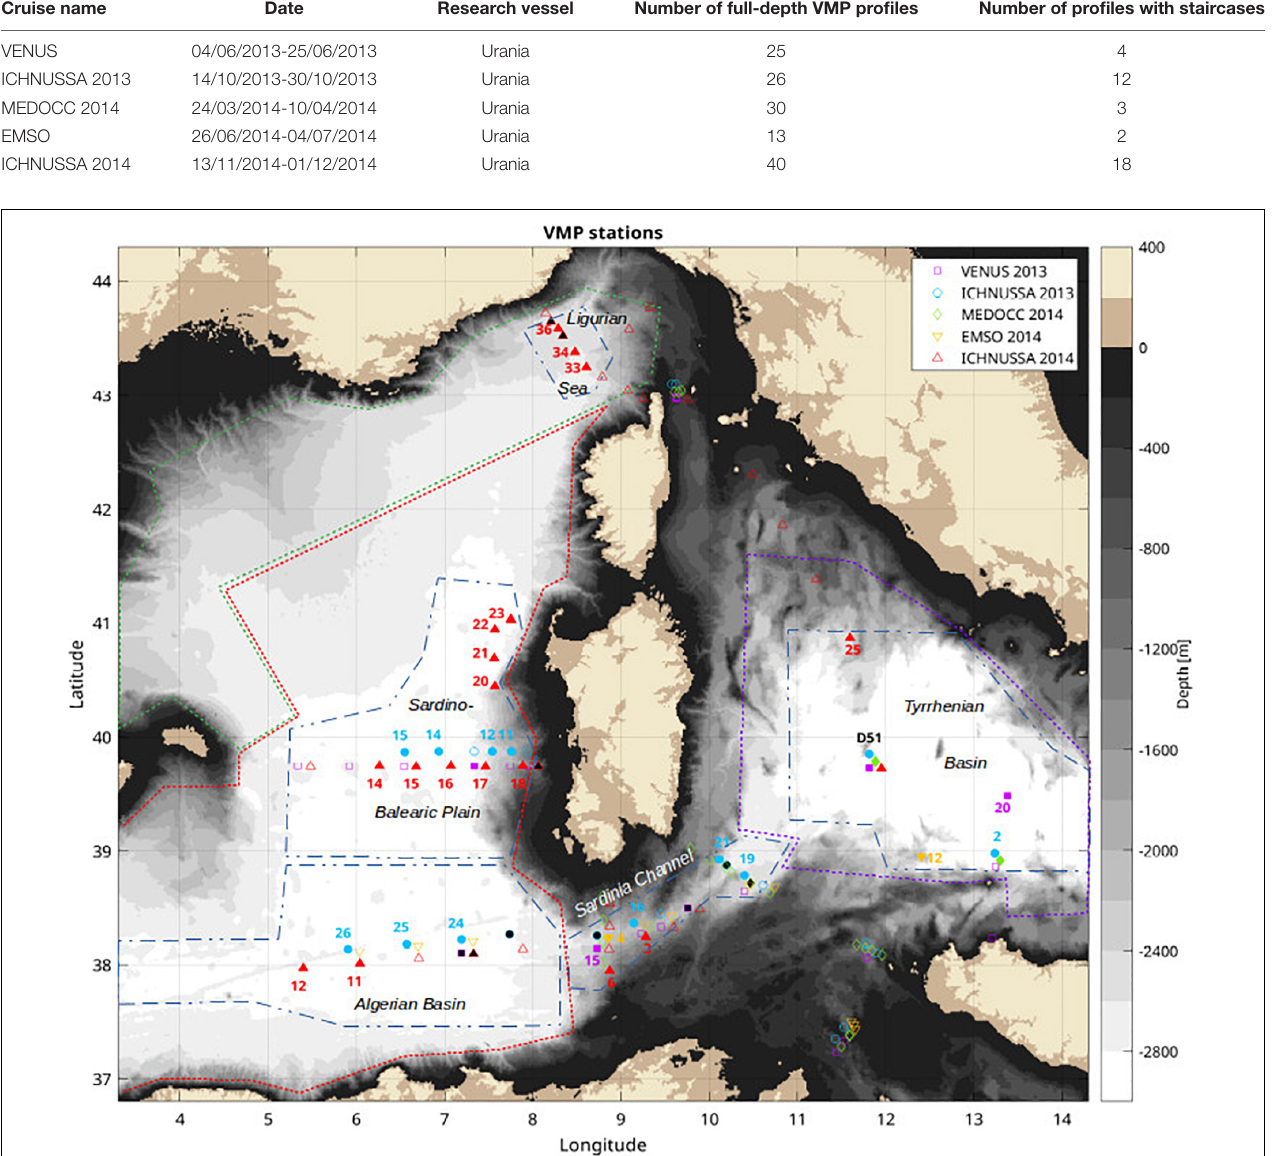
FIGURE 1 | Location of VMP stations gathered along five cruises done in 2013 and 2014. Each cruise has specific color and marker. For clarity, markers are offset around the VMP cast location to distinguish between cruises for a same station. When staircases with clear alternating steps and layers are observed on a profile, the marker is filled with the corresponding cruise color. Markers filled with black correspond with stations showing some smooth or fuzzy staircases that are not taken into account in this study. Unfilled markers are stations without any obvious staircases. Note that the numbering of a same station usually differs from a cruise to the other. Blue dashed-dotted lines delineate the maximum area attributed to the four regions showing staircases. The area of the Algerian Sea extends up to the Alboran Sea and that of the Tyrrhenian Sea extends slightly further eastward (cut for clarity). Colored dotted lines are used to delineate regions for mechanical mixing estimates: red for the Algerian Sea to the Northern boundary layer, green for the boundary layer, purple for the Tyrrhenian Sea, Sardinia Channel remains delimited by the blue dashed-dotted